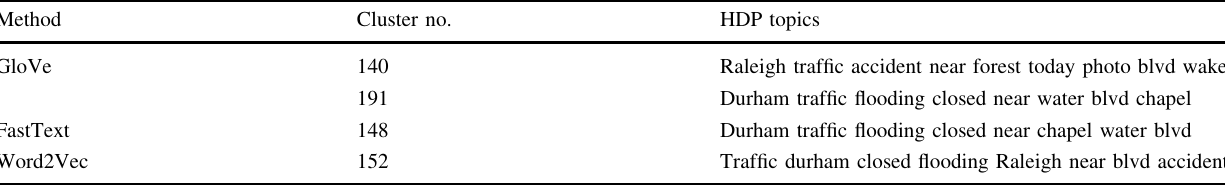
Table 7 Extracted topic keywords by hierarchical Dirichlet process (HDP) for GloVe, FastText, and Word2vec related to Hurricane Florence in North and South Carolina